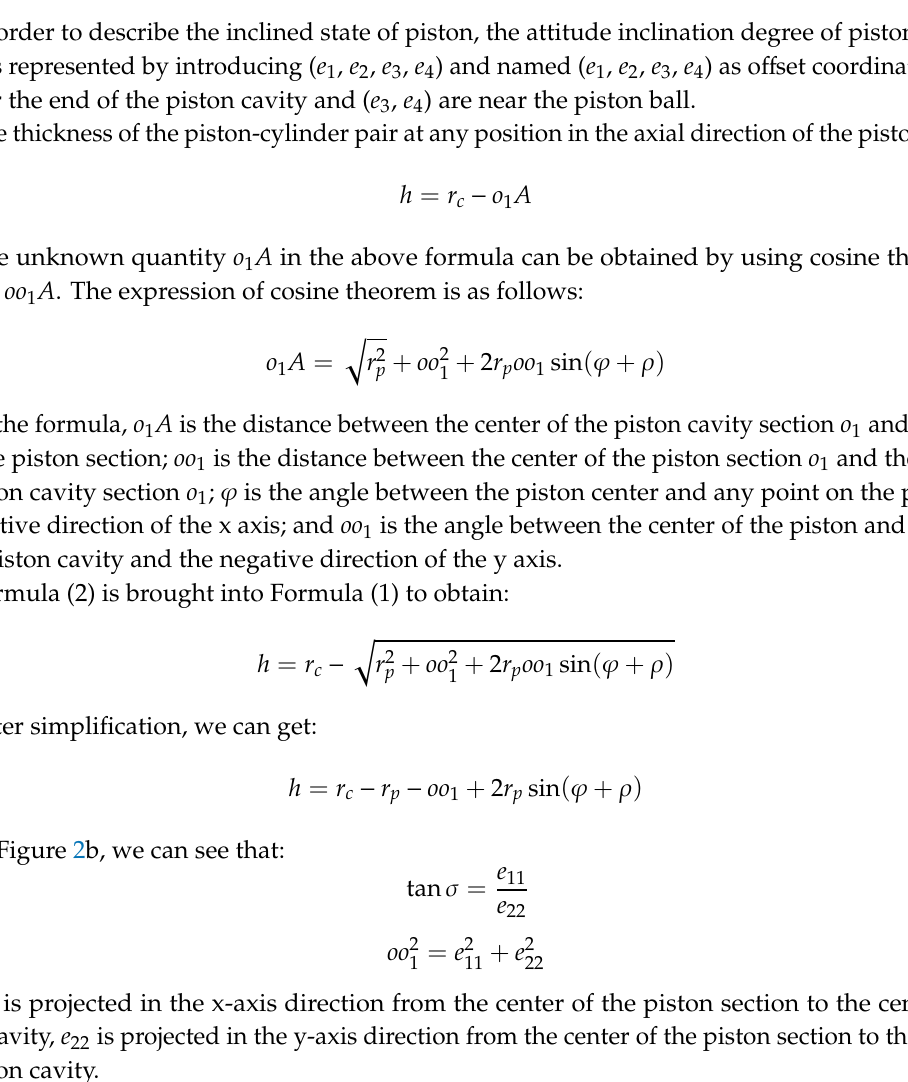
Figure 2. ( a ) Attitude diagram of piston in piston cavity; ( b ) variable schematic diagram at cross section of piston end face.